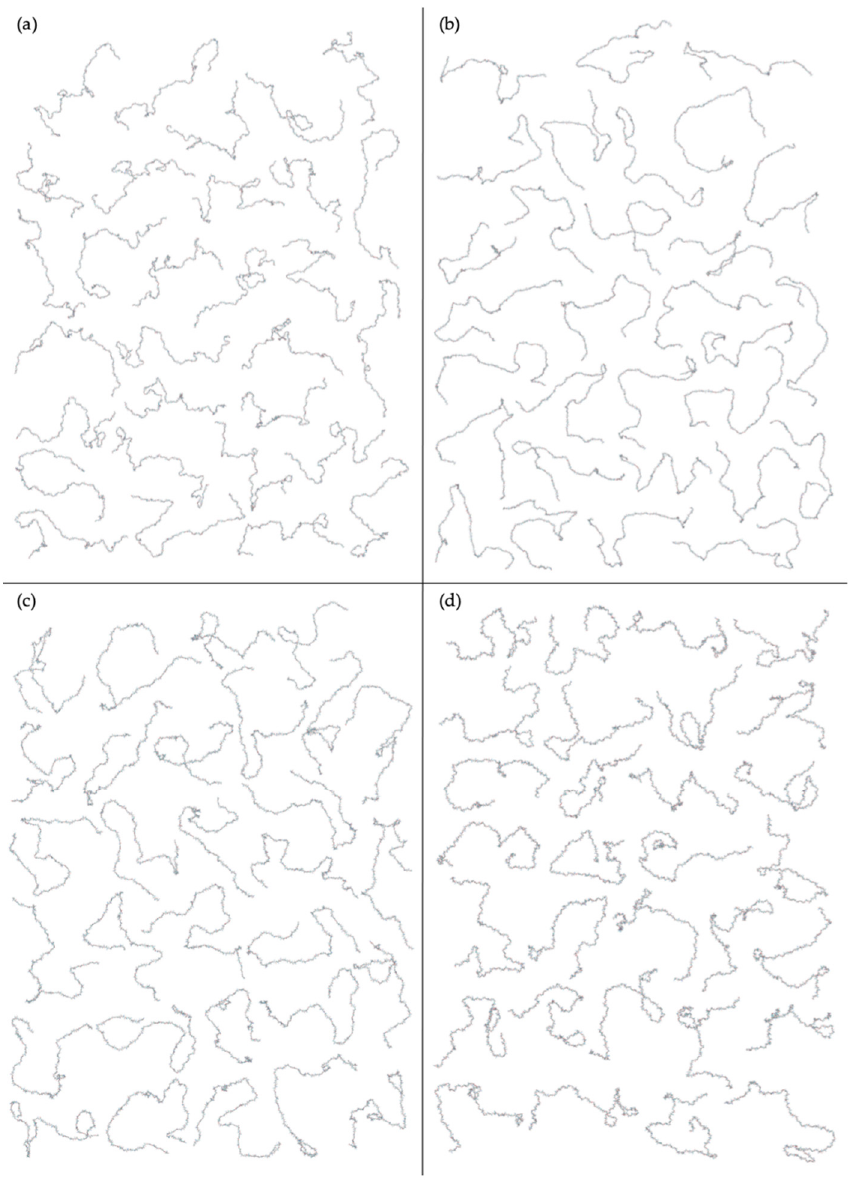
Figure 24. Constructed 200-mer conformations with probable end-to-end distances for each GAG type: ( a ) hyaluronan, ( b ) nonsulfated dermatan, ( c ) nonsulfated keratan, ( d ) nonsulfated heparan; n.b. depth is not shown, so some conformations appear to have overlap.